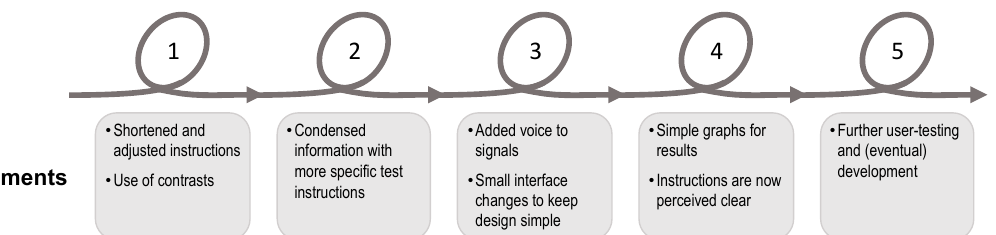
Figure 4. An overview of the design process, describing developments made after each of the five co ‐ creation sessions and consequently further explored in the next iteration.